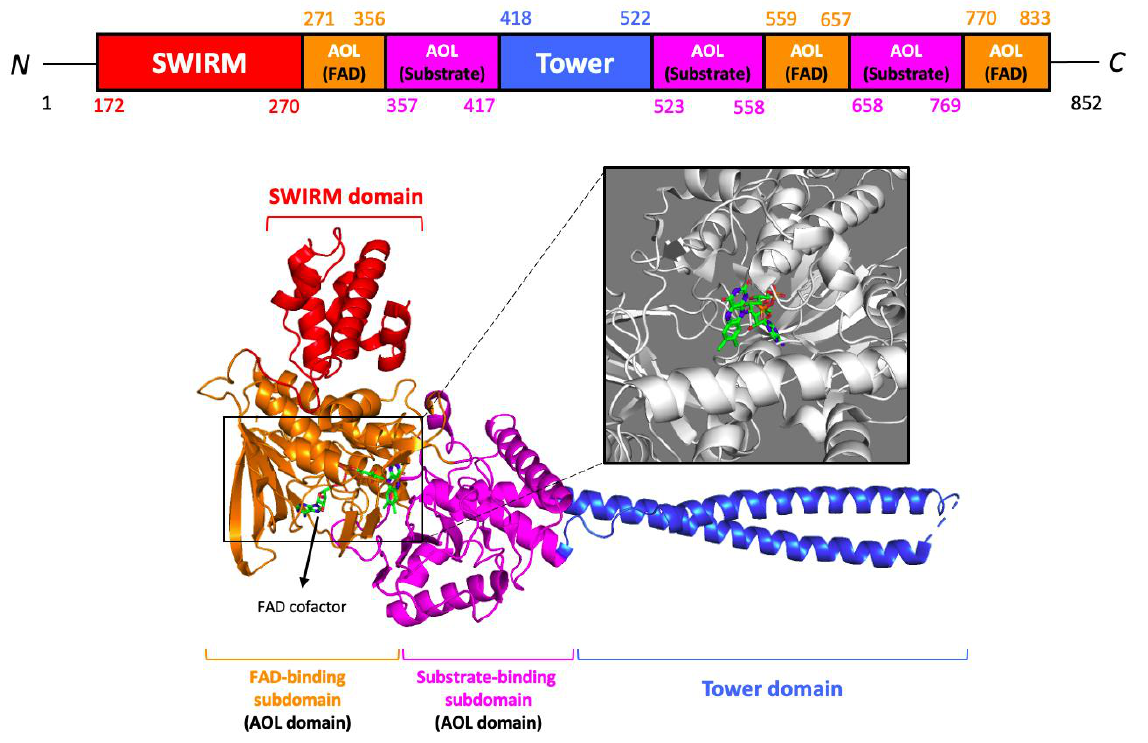
Figure 4. Ribbon structure of lysine-specific demethylase 1 (LSD1). The SWIRM domain is colored red, the AOL domain is colored orange (FAD-binding subdomain) and purple (substrate-binding subdomain), and the Tower domain is colored blue. FAD cofactor is displayed as a stick model. Data on the X-ray diffraction structure were obtained from Protein Data Bank (PDB) [accession no. 2HKO]. Figures were prepared using the programs of PyMOL molecular visualization systems.